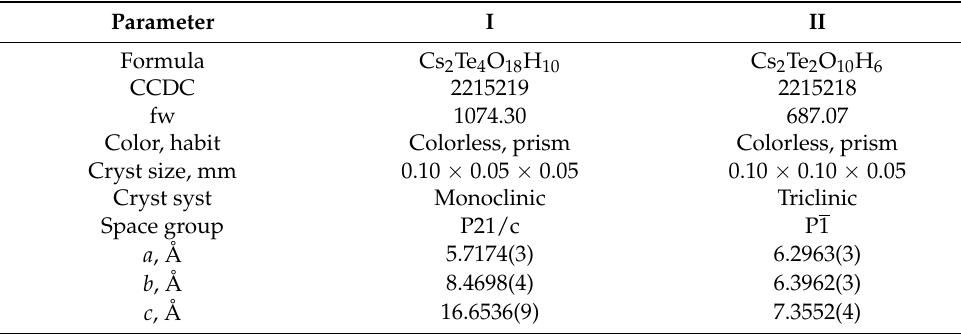
Table 2. Crystal data, data collection, and refinement parameters for I and II